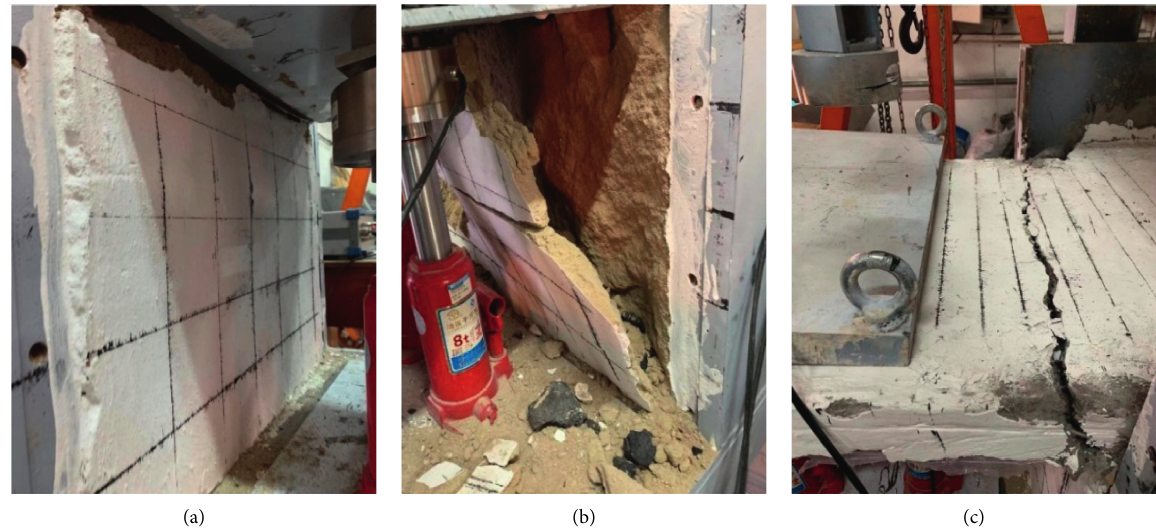
Figure 4: Roof and face failures of the physical models under dynamic roof loading: (a) face buckling; (b) face fall; (c) roof fall.